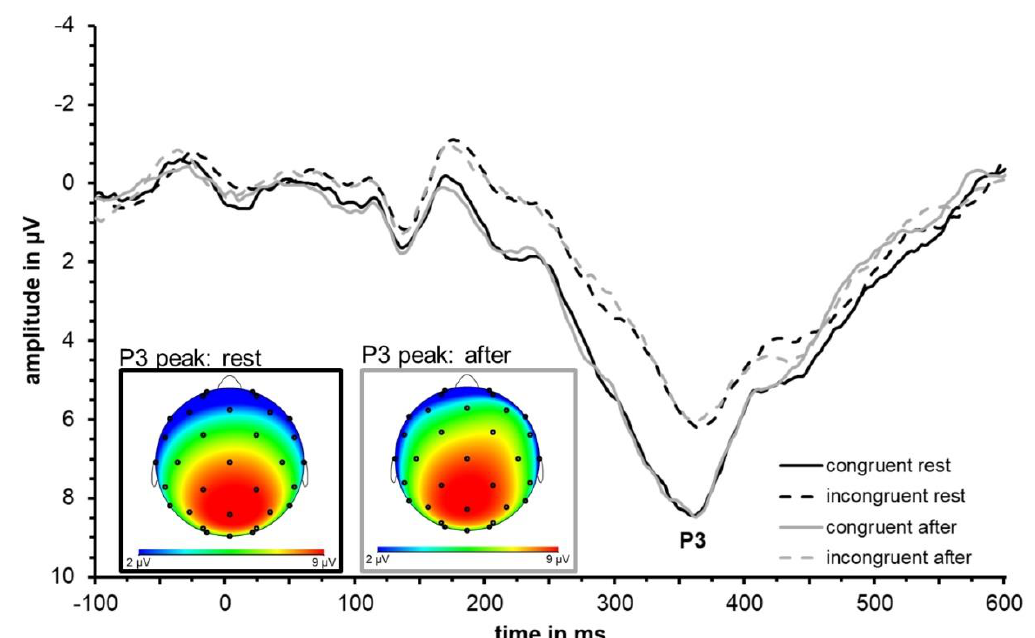
Table 5. Mean (SD) P3 peak latencies and amplitude for congruent and incongruent conditions at rest and after exercise at electrode site Pz.